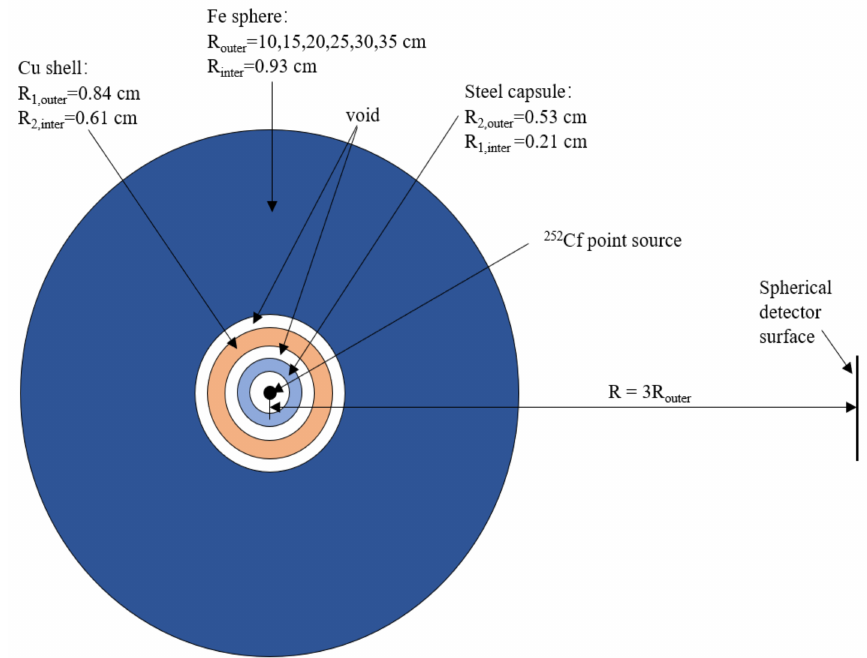
Figure 9. Geometry model of the ALARM-CF-FE-SHIELD-001